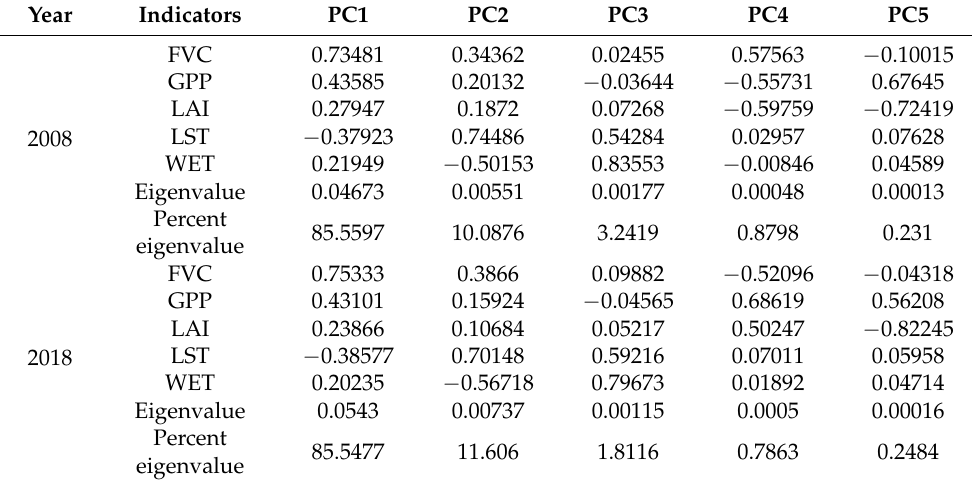
Table 2. Principal component